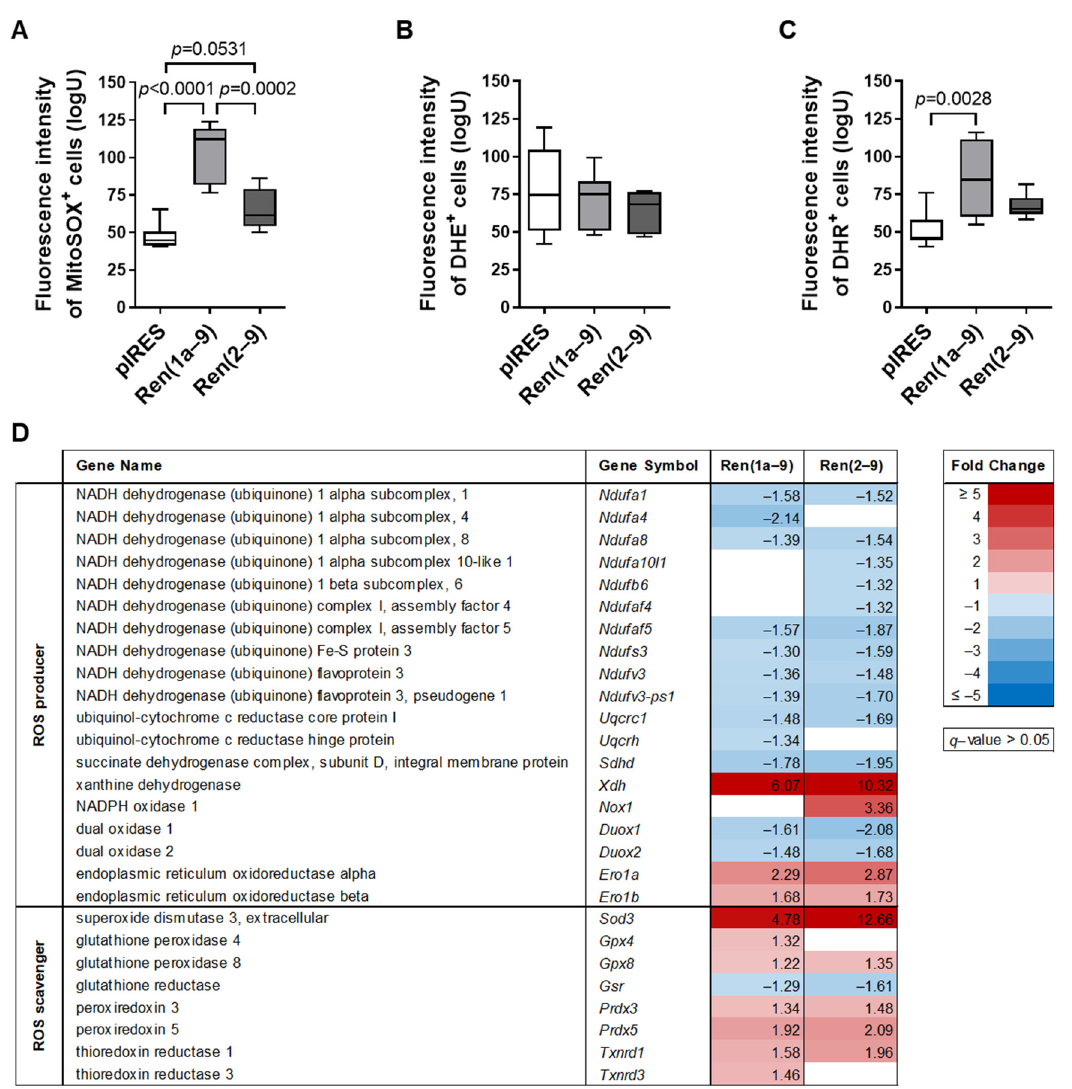
Figure 8. Renin-b-induced alterations in mitochondrial and cytosolic ROS accumulation. ( A ) In- creased fluorescence intensity (FLI) of MitoSOX-positive cells, ( B ) unchanged FLI of dihydroethidium (DHE)-positive cells, and ( C ) increased FLI of dihydrorhodamine (DHR)-positive cells as a result of either Ren(1a–9) or Ren(2–9) overexpression as compared with pIRES H9c2 control cells. ( D ) Alterations in the expression of genes coding for reactive oxygen species producers or scavengers as identified by transcriptome analyses. Shown are only significantly altered genes ( q < 0.05) that exhibited a fold change of ≥ |1.3| in at least one group comparison. ( A – C ) Data of 7–9 independent experiments per group are shown as box plots, where the top of the box represents the 75th percentile, the bottom of the box represents the 25th percentile, and the line in the middle represents the median. The whiskers represent the highest and lowest values in the dataset. The data were analyzed by one-way ANOVA followed by Tukey’s test. Single p –values < 0.1 vs. pIRES controls or as indicated are given in the figure.